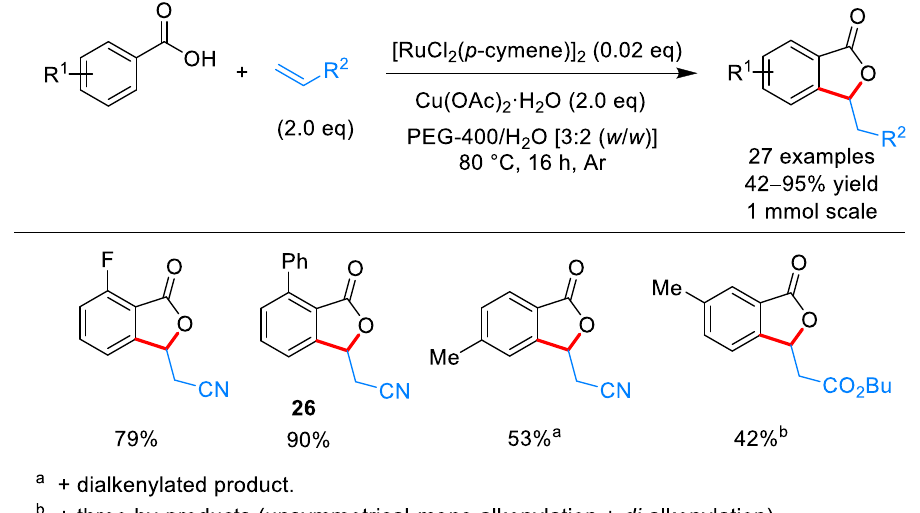
PEG-400/water for the synthesis of 3-substituted